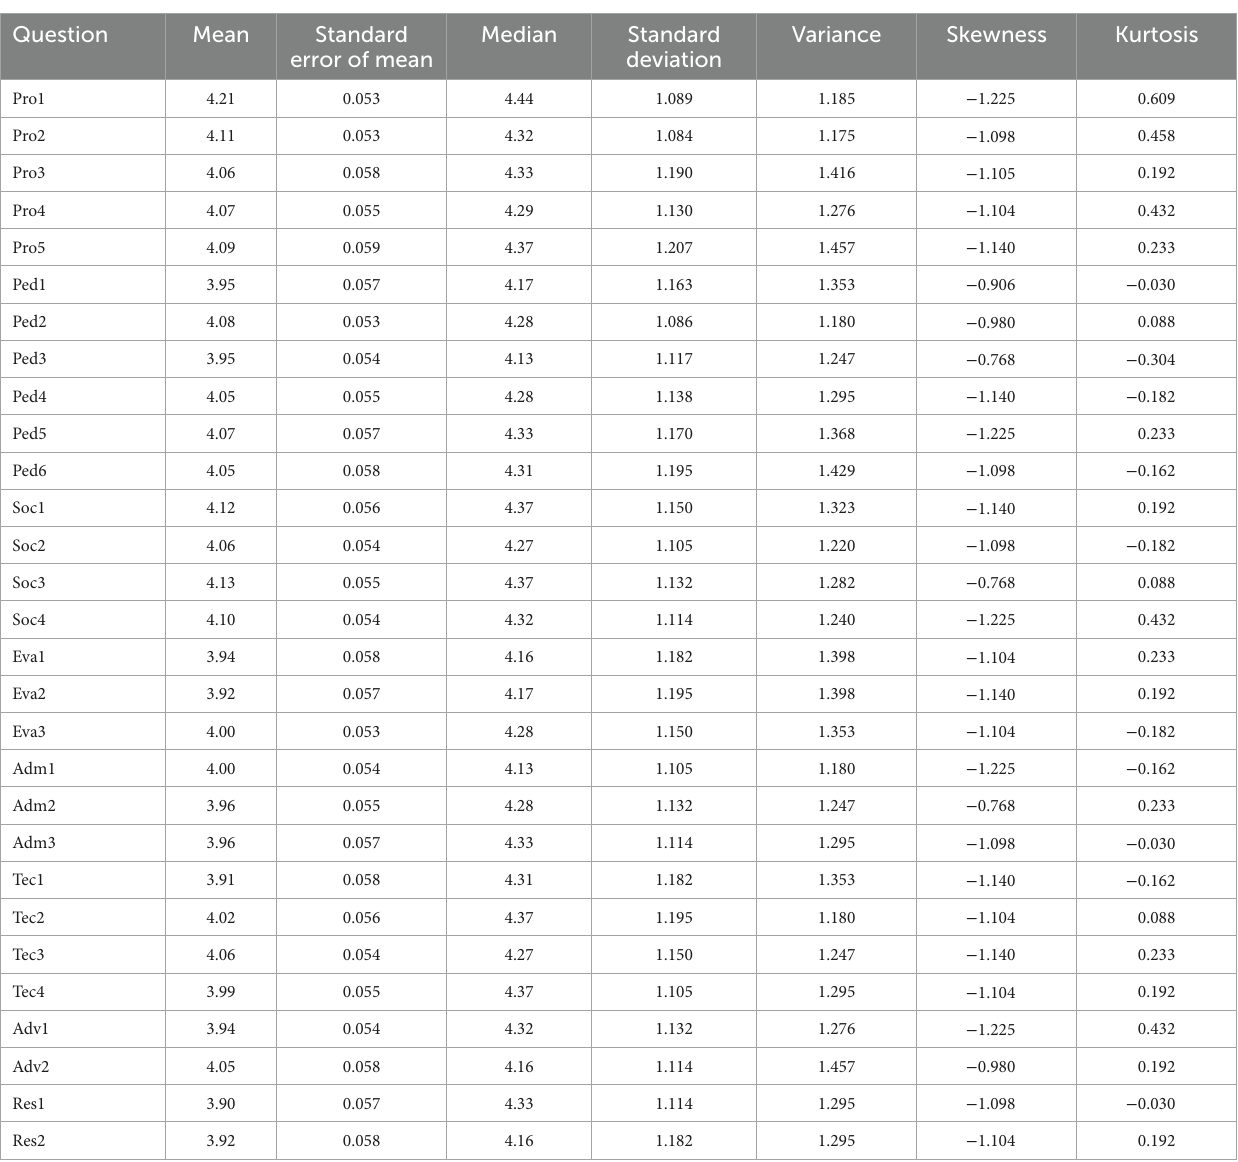
TABLE 4 Data analysis indicator of